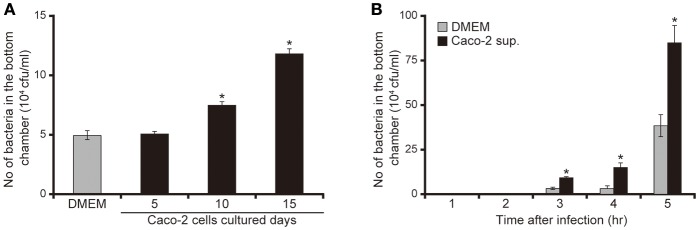
Caco-2 cell supernatant facilitates penetration of the P. aeruginosa PAO1 strain through the mucin layer. (A) The bottom chambers of Transwell cells were filled with Caco-2 cell supernatant (collected after 5, 10, and 15 days of culture) or with Dulbecco's modified Eagle medium (DMEM; control). The P. aeruginosa PAO1 strain was added to the top chamber. After 3 h, the numbers of bacteria in the bottom chambers were counted. Error bars indicate standard error (n = 3). *P < 0.05 compared with DMEM. (B) Caco-2 cell supernatant after 15 days of culture (Caco-2 sup.) or DMEM (control) filled the bottom chamber of Transwell cells. After the P. aeruginosa PAO1 strain was added, the numbers of bacteria in the bottom chambers were counted at 3, 4, and 5 h. Error bars indicate standard error (n = 3). *P < 0.05 compared with DMEM at the same incubation time.